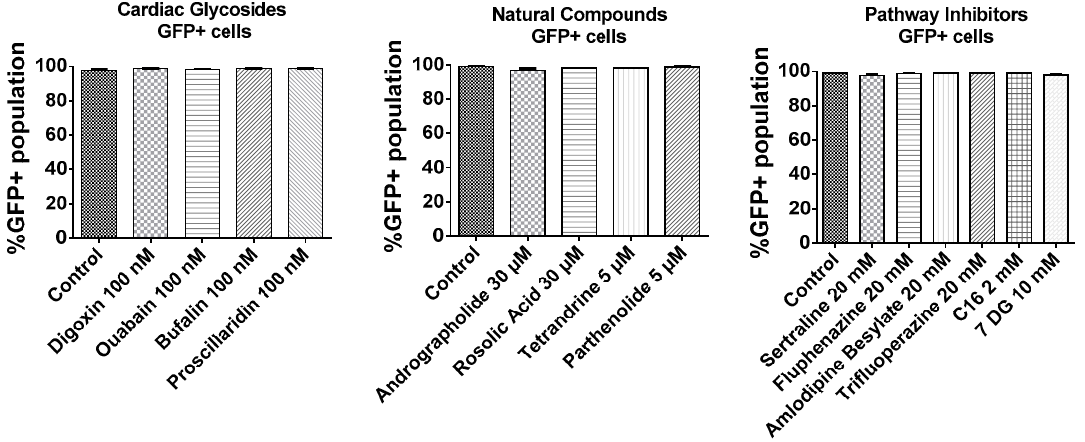
Figure 3. Transfection efficiency of BJ fibroblasts based on %GFP+ population. BJ fibroblasts were incubated with small molecules for 1h followed by a 3 h transfection with GFP mRNA nanoparticles in the presence of the small molecules. Cells were further incubated in complete media without small molecules for another 4 h and analyzed by flow cytometry.